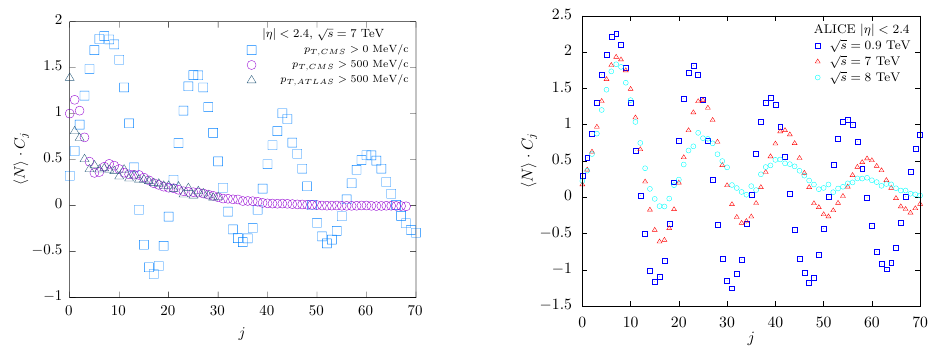
Figure 2. Left panel: The C j oscillations across di ff erent transverse momentum cuts from data in [5]. Once again, data from a larger phase space volume of p T > 0 MeV / c exhibits more significant oscillation. Right panel: C j plotted across various centre-of-mass energies at the same pseudorapidity interval of | η | < 2 . 4 from ALICE